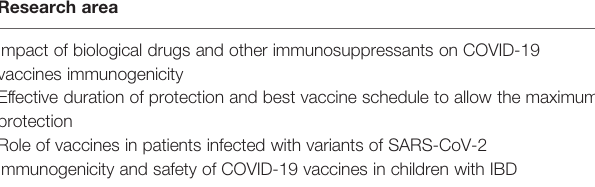
TABLE 2 | Priorities for studies on COVID-19 vaccines in patients with in fl ammatory bowel disease (IBD). Research